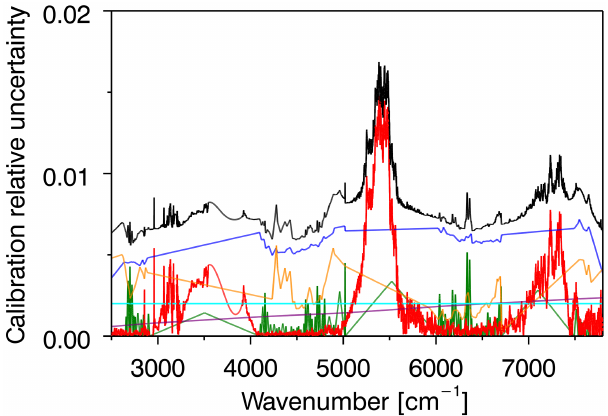
Figure 6. Relative 2 σ calibration uncertainty excluding the contri- bution due to ESS inaccuracies, which his discussed in Sect. 4.2 (Langley measurements made on 13 December 2013; blackbody measurements on 24 February 2014). Blue: Langley fit uncertainty; red: blackbody uncertainty; green: shape error uncertainty; orange: air mass uncertainty; purple: mispointing uncertainty; cyan: FOV uncertainty; black: total uncertainty relevant for radiative closure experiment (not including ESS